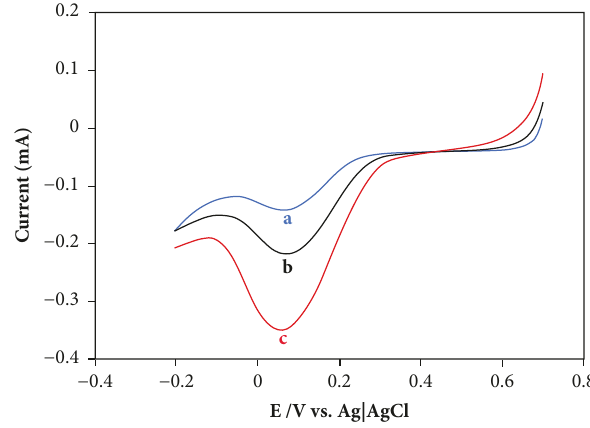
Figure 7: The FTIR spectrum of GOx (a), CC coated chitosan (b), and GOx immobilized CS/CC (c).